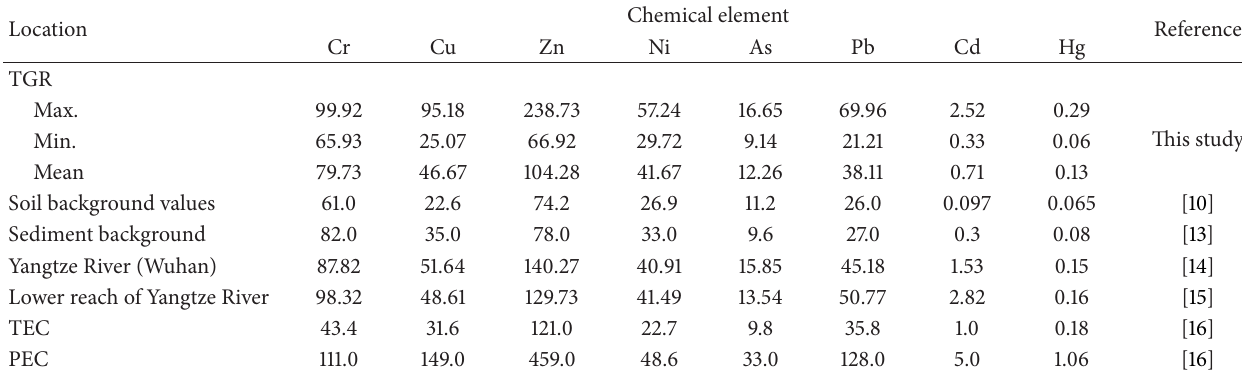
Table 3: The levels of heavy metals in surface sediments from TGR tributaries and other rivers in China.